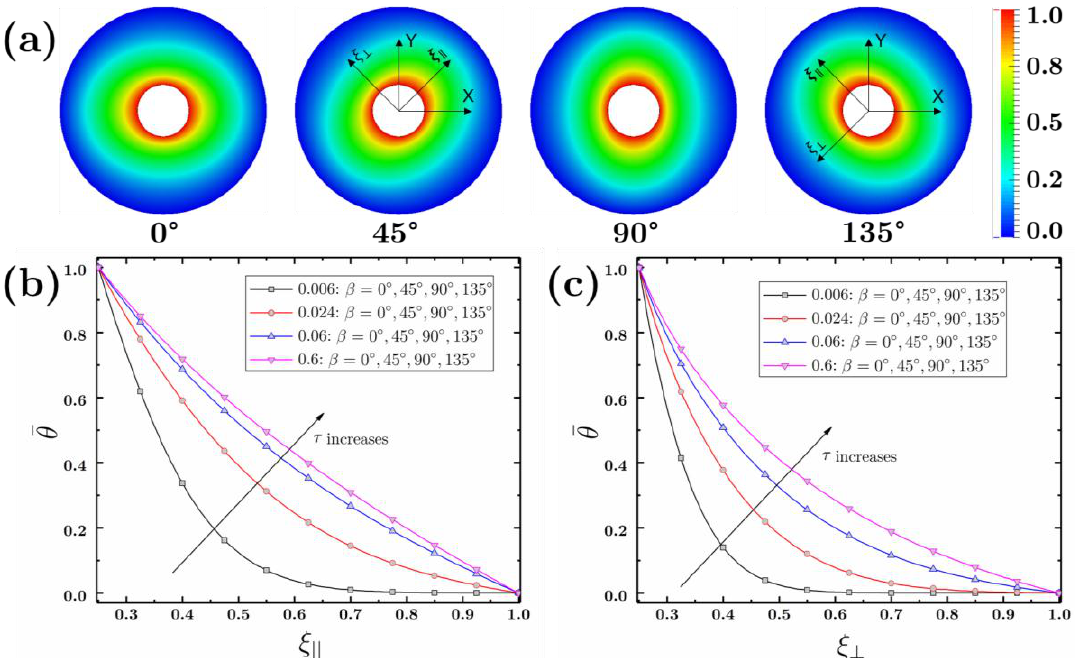
Figure 4. The effect of changing the direction of the magnetic field on thermal bahavior at Ha = 1.0 and φ = 0.05: ( a ) steady-state temperature distribution; ( b ) temperature profiles along the direction of the magnetic field at different dimensionless times; ( c ) temperature profiles perpendicular to the direction of the magnetic field at different dimensionless times.